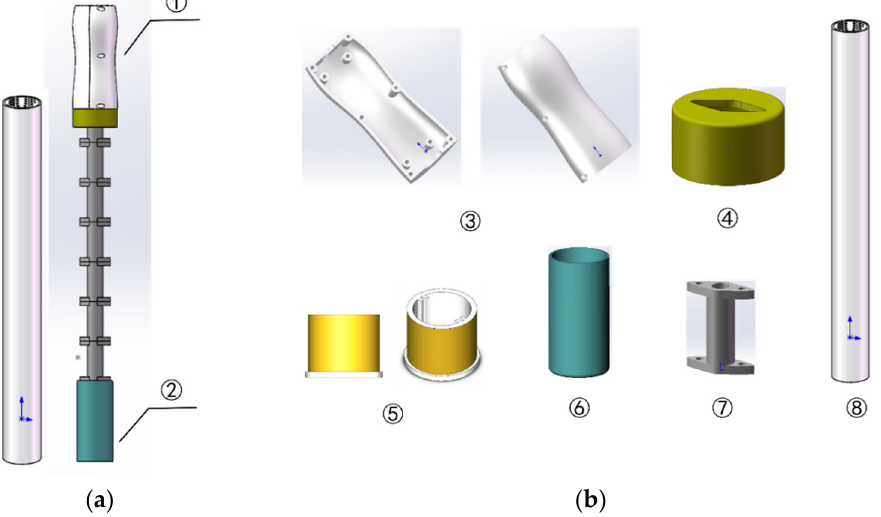
Figure 11. Sensor housing structure. ( a ) Assembly drawings; ( b ) component drawing. ① Isolation tube data processing unit; ② moisture-sensing probe; ③ upper and lower chambers of the moth- erboard; ④ card slot; ⑤ probe upper and lower brackets; ⑥ probe sleeve; ⑦ segmented tie rod; ⑧ isolation